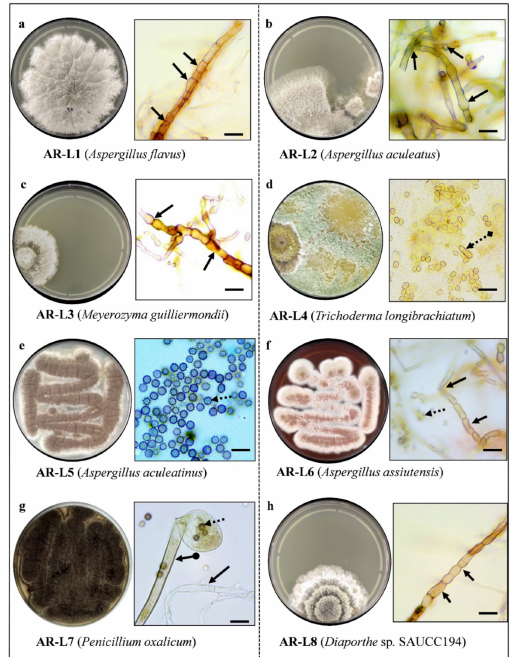
Figure 1. Pictorial representation of isolated fungal colony on PDA plate after 7 days of incubation and their microscopic view of fungal endophytes ( a ) A. flavus , ( b ) A. aculeatus , ( c ) M. guilliermondii , ( d ) T. longibrachiatum , ( e ) A. aculeatinus , ( f ) A. assiutensis , ( g ) P. oxalicum and ( h ) Diaporthe sp. SAUCC194 at 100 × under bright field microscope. Mycelial septa (